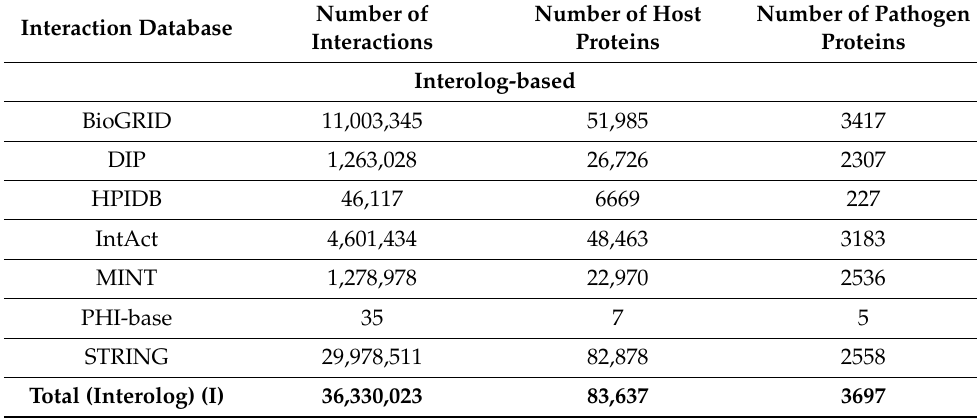
Table 2. Predicted PPIs in T. aestivum – T. laevis interactome. Interaction